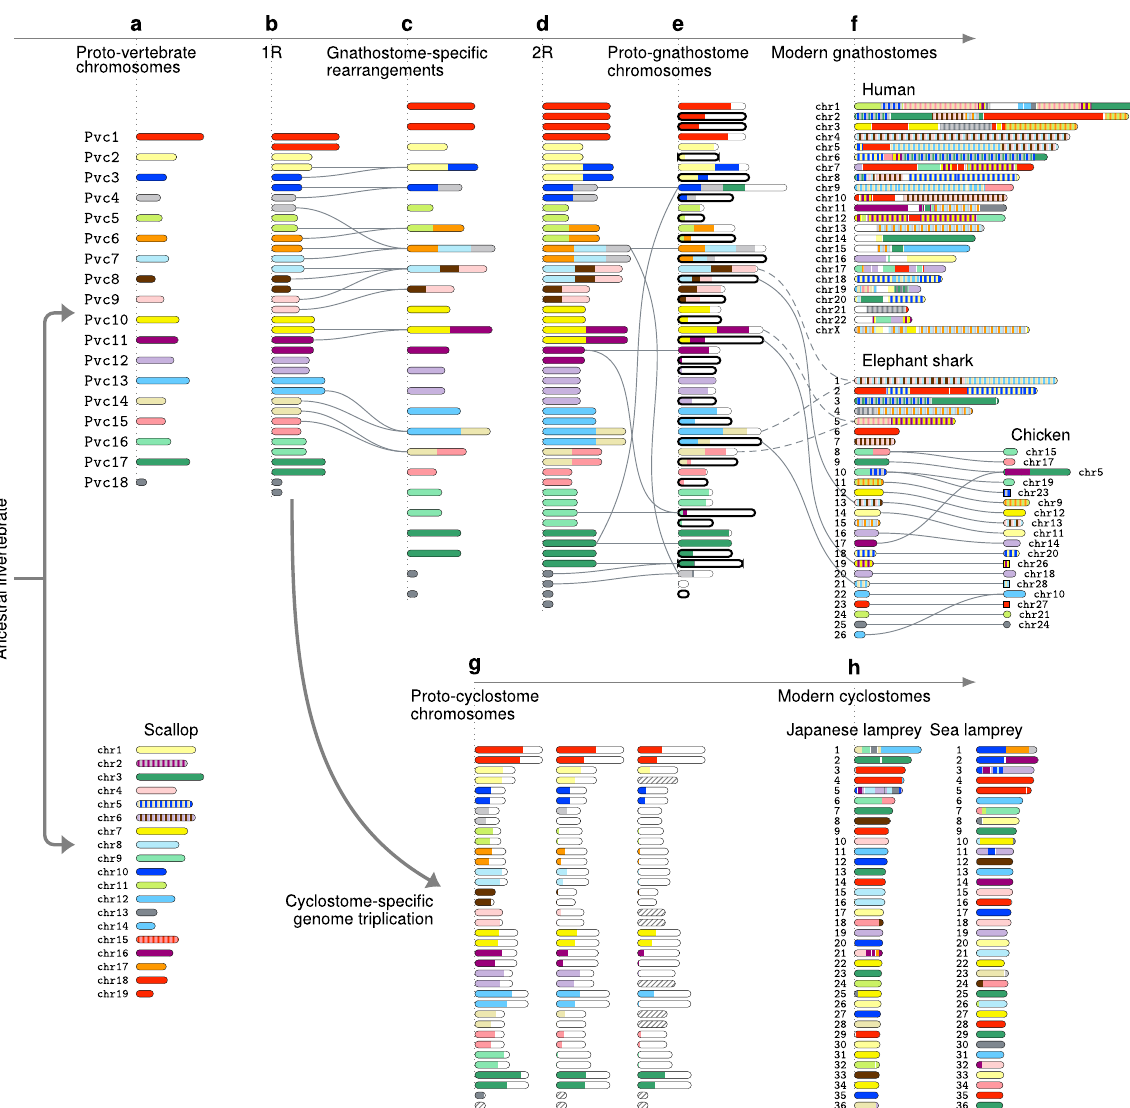
Fig. 6 Inferred scenario of the early vertebrate genome evolution. a The 18 proto-vertebrate chromosomes show strong macrosynteny conservation in the scallop genome. Scallop chromosomes are coloured to indicate homology with proto-vertebrate chromosomes, where stripes indicate homology to multiple proto- vertebrate chromosomes. b The fi rst tetraploidization (1R) doubled the proto-vertebrate chromosomes. c The post-1R genome experienced nine chromosome fusions, which were not shared with the proto-cyclostome lineage. d The second tetraploidization (2R) established the proto-gnathostome genome with 49 chromosomes after a few post-2R fusions. e The duplicated proto-gnathostome chromosomes exhibit biased gene loss/retention, as indicated by different lengths of coloured bars (see Supplementary Note 4 for details). Chromosomes surrounded by a thick line belong to the shorter subgenome (with a higher rate of gene loss). f Chromosomal regions in modern gnathostome genomes were painted according to the originating proto-gnathostome chromosomes, where stripes indicate fusion chromosomes in the proto-gnathostome genome (e.g. human chr9 was derived from Pvc13, 14 and 15). The largest 26 elephant shark scaffolds and selected chicken chromosomes demonstrate the persistent conservation of microchromosomes. The 2R event duplicated fused chromosomes, each of which gave rise to a large chromosome (dashed lines) and a microchromosome (solid lines) in elephant shark and chicken, which suggests that microchromosomes were created by biased gene fractionation after 2R. g The cyclostome lineage diverged from the gnathostome lineage shortly after 1R, and the proto-cyclostome genome was formed by hexaploidization. Coloured bars show biased gene loss/retention, and chromosomes missing in our reconstruction are shown as hatched bars. h The largest 36 scaffolds in modern lamprey genomes were painted according to their originating proto-vertebrate